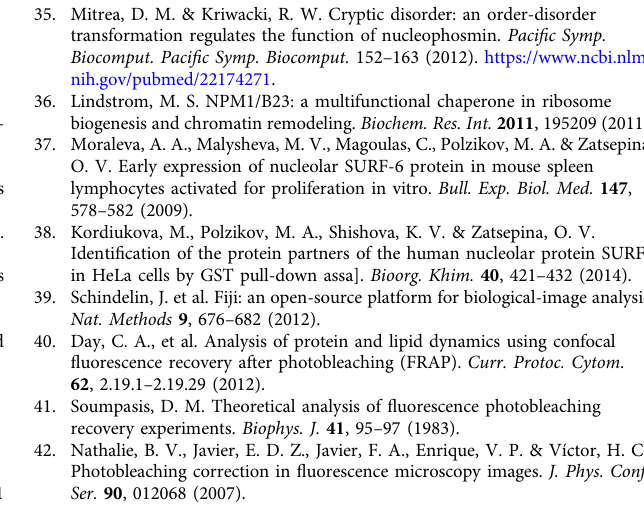
Fig. 17. Images were acquired at the Cell & Tissue Imaging Center which is supported by St. Jude Children ’ s Research Hospital and NCI P30 CA021765; we thank Dr.